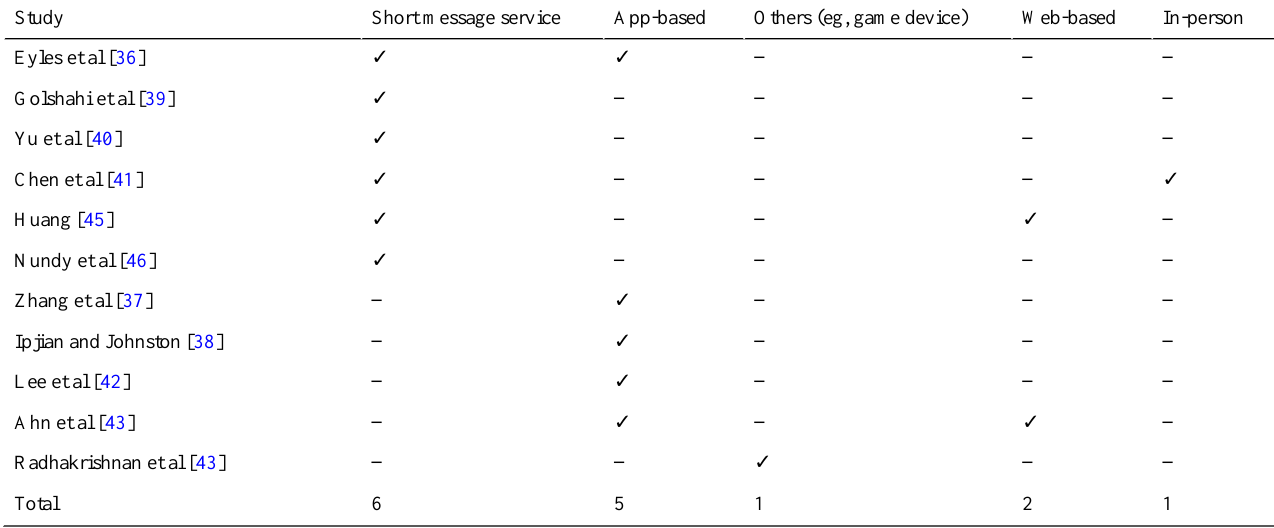
Table 2. Technologies used in the randomized controlled trials and quasi-experimental studies (n=11). A checkmark indicates that the technology was observed in the study, while an em dash indicates that it was not.